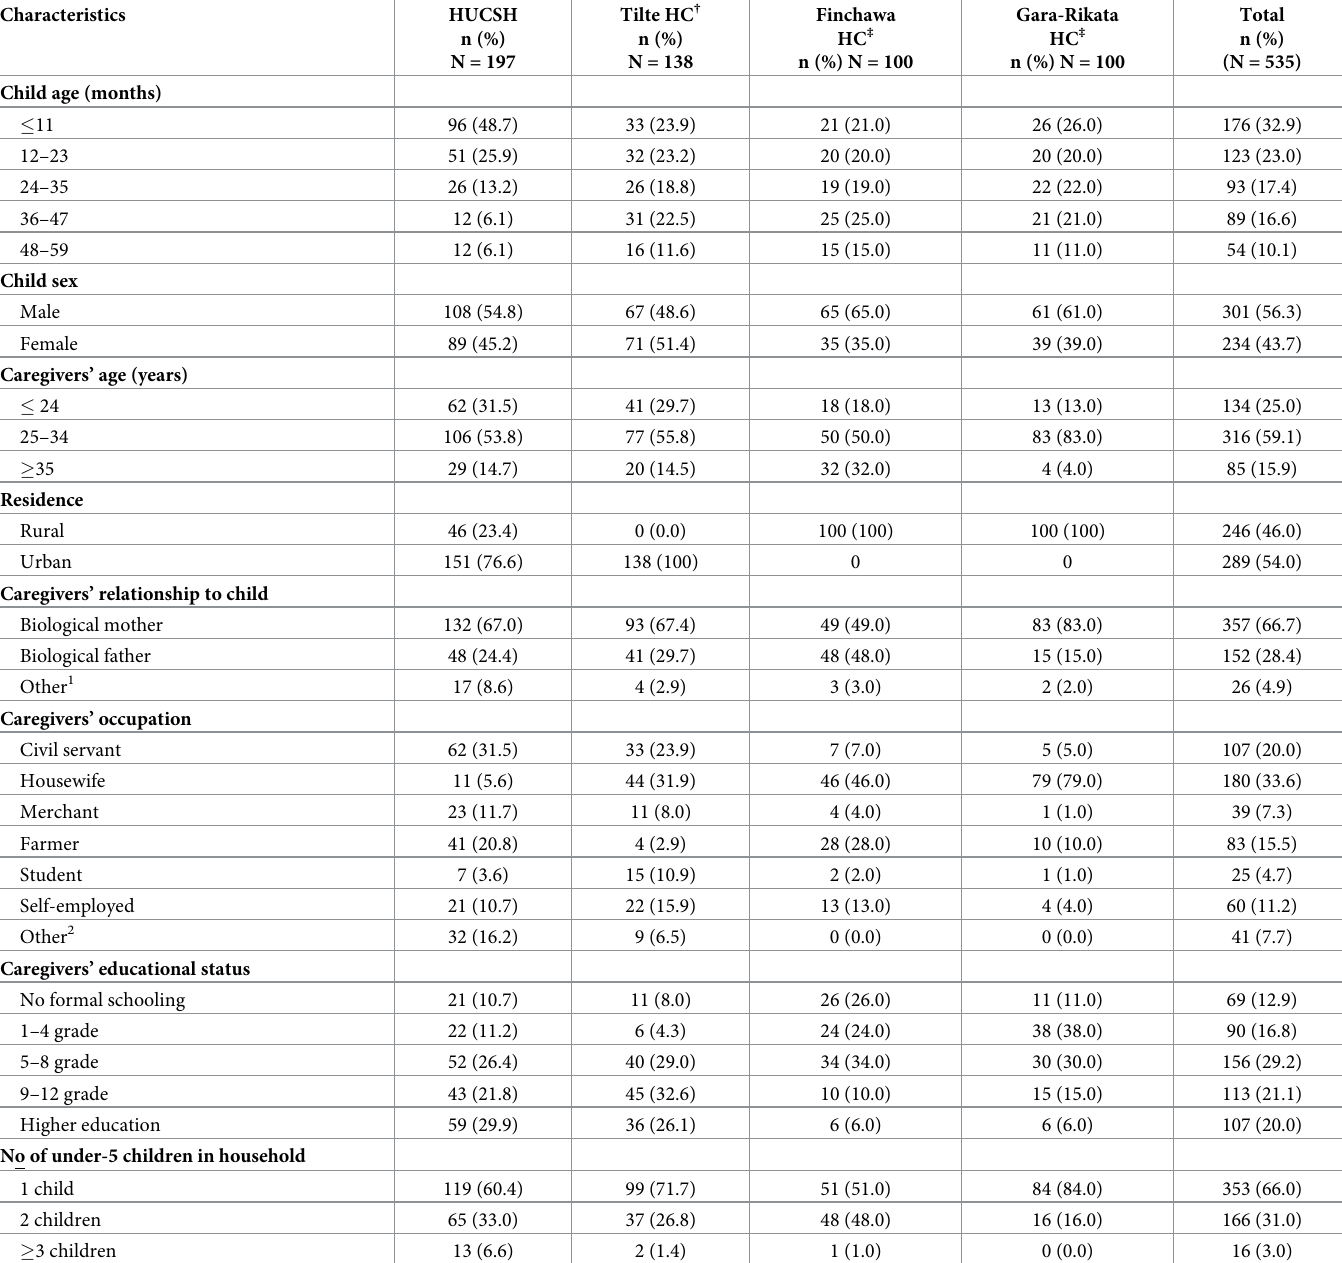
Table 1. Socio-demographic characteristics of febrile children and caregivers attending health facilities in Hawassa City, 2019 (N = 535).